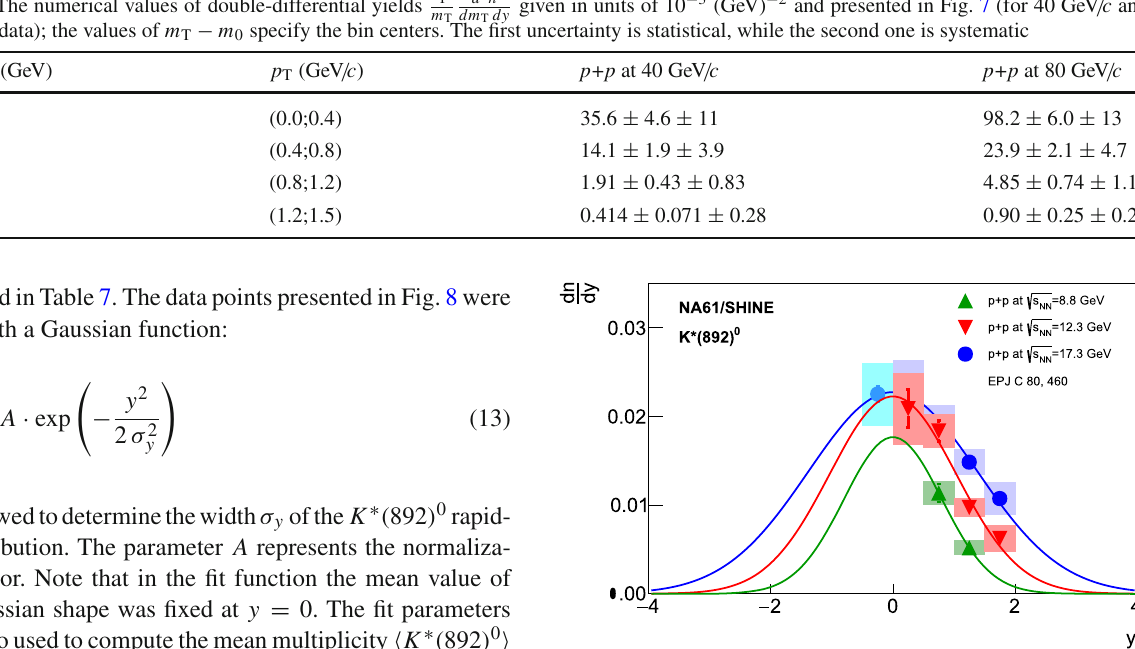
d 2 n given in units of 10 − 3 (GeV) − 2 and presented in Fig. 7 (for 40 GeV / c and m T dm T dy